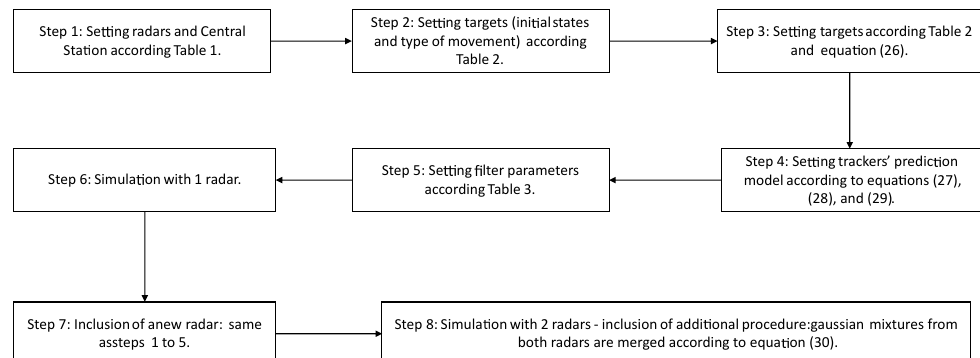
Figure 3. Block diagram of the proposed